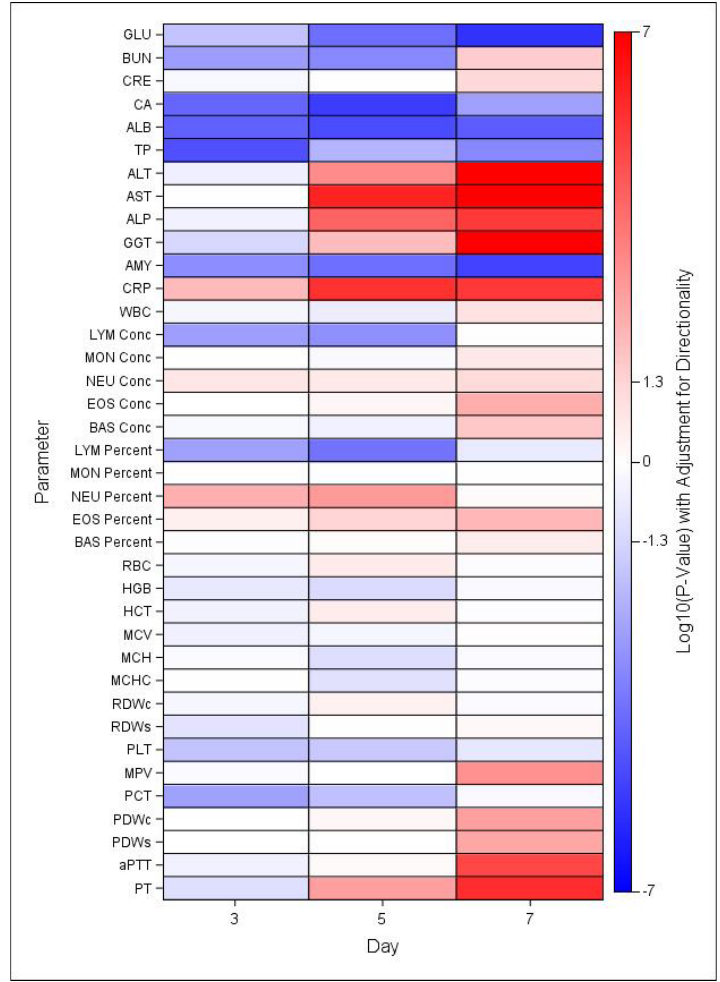
Figure 6. Heat Map of Statistical Differences between the MARV-Exposed and Mock-exposed Groups. Heatmap indicating mean increases (red) or decreases (blue) in MARV-exposed group in comparison to mock-exposed control group, based on log-transformed p -values adjusted for directionality. Significant differences indicated for values >1.3 or < −1 .3, where log10(0.05) = 1.3.